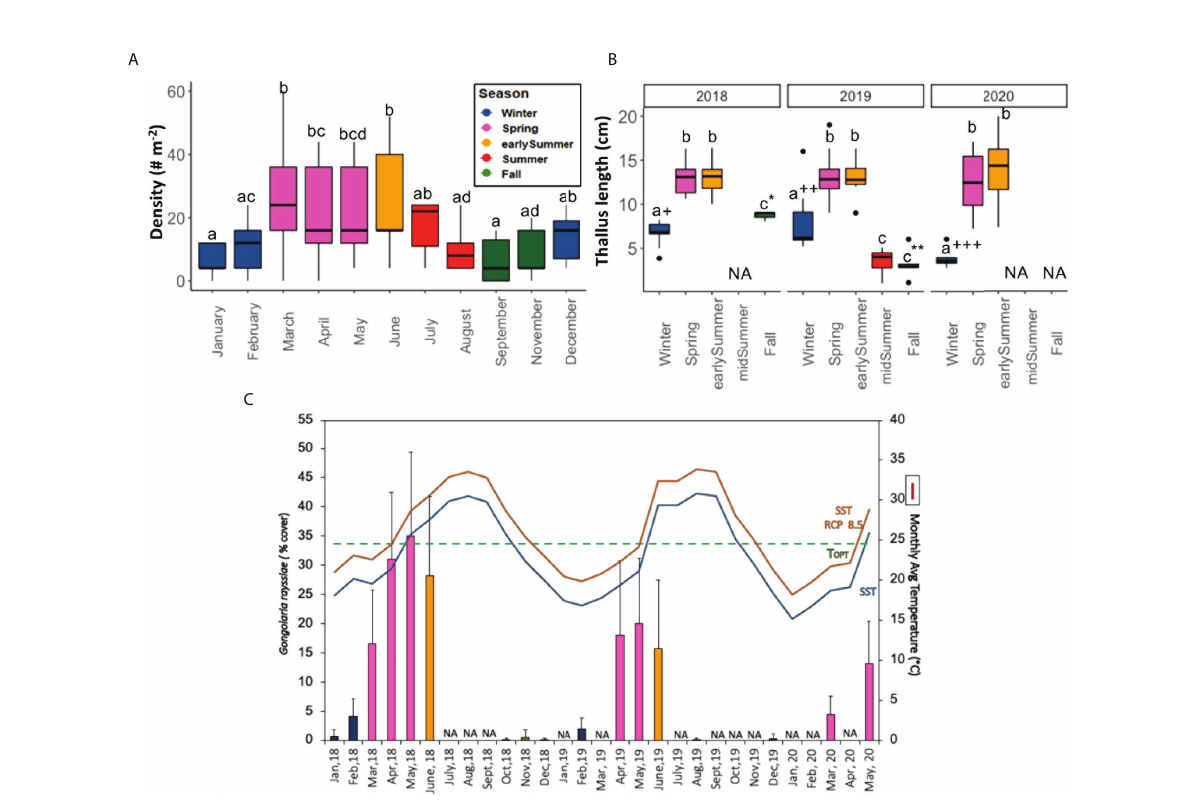
FIGURE 1 Temporal dynamics of Gongolaria rayssiae in the Tel-Shimona site during the period 2018 – 2020, based on the permanent quadrats (50x50 cm 2 ) seasonally visited throughout the entire period and monthly during 2019: (A) Density of individual plants per m 2 recorded in 2019 ( ± SD); (B) Seasonal maximum thallus length (cm ± SD) throughout the study period; (C) Monthly percentage cover ( ± SD) over three years (January 2018-May 2020). Temperature is plotted with a blue line, while the orange one is the RCP 8.5 (3°C higher than today); dashed green line indicates G.rayssia e ’ s T OPT . Signi fi cant differences within the same year are reported with different letters, while symbols represent comparisons between same season in different years (p < 0.05) (n= 5 – 9). NA = not available